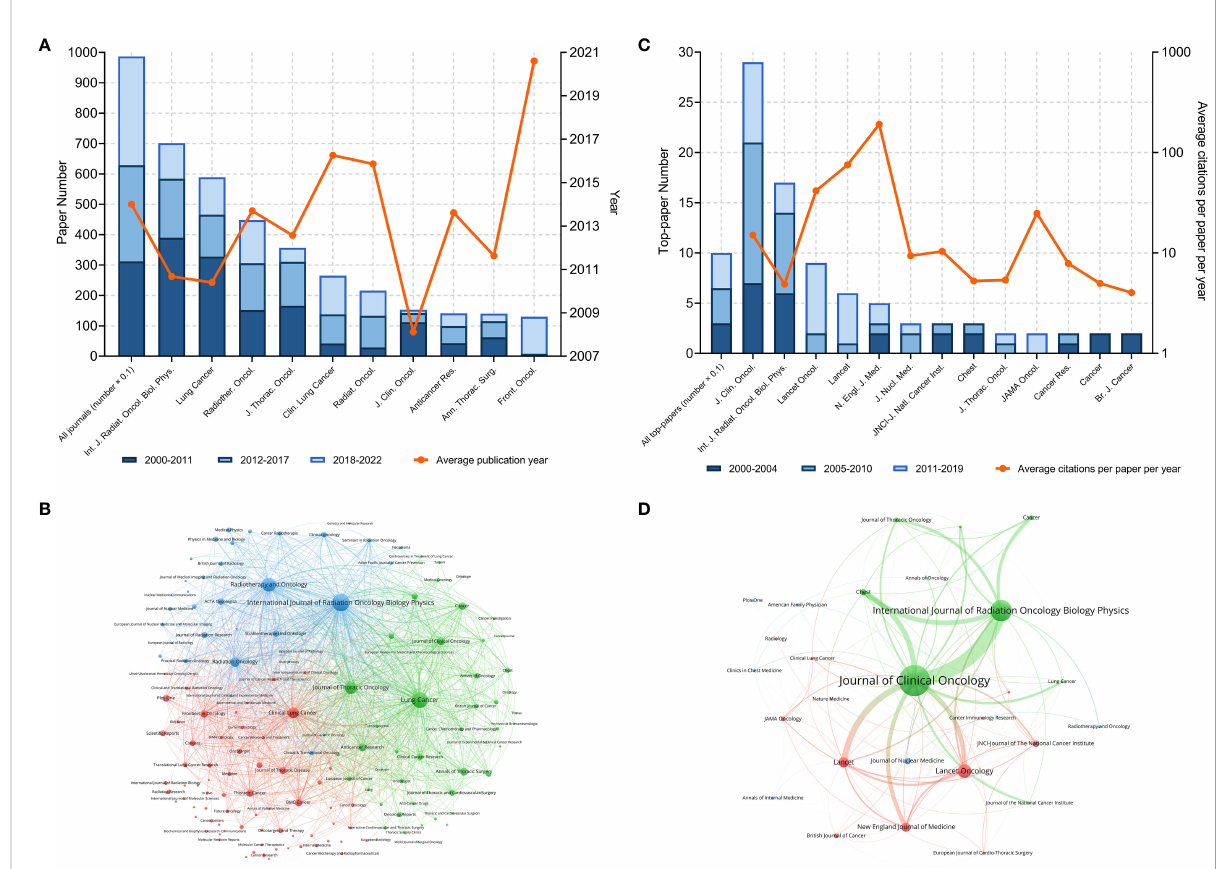
FIGURE 2 (A) Article numbers and average publication year of the articles of the top-10 productive journals. (B) Bibliographic coupling of journals with at least ten papers related to lung cancer radiotherapy. (C) Top-paper number and average citation per paper per year of the journals with at least two top-papers. (D) Bibliographic coupling of journals with top-papers related to lung cancer radiotherapy. In the bibliographic coupling maps, the circle size represents the number of papers. The breadth of the curves represents the connection strength. The journals in the same color are of similar research areas.